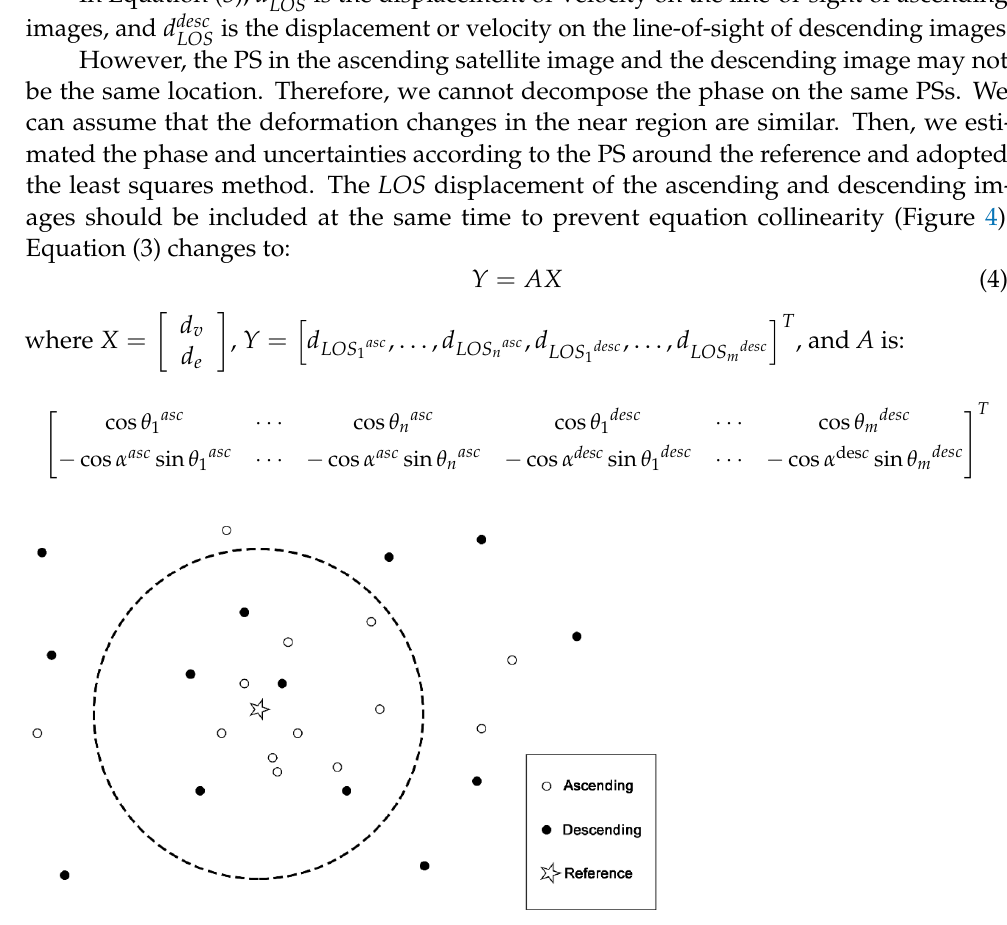
Figure 4. The selection of the PS correction point in the reference PS